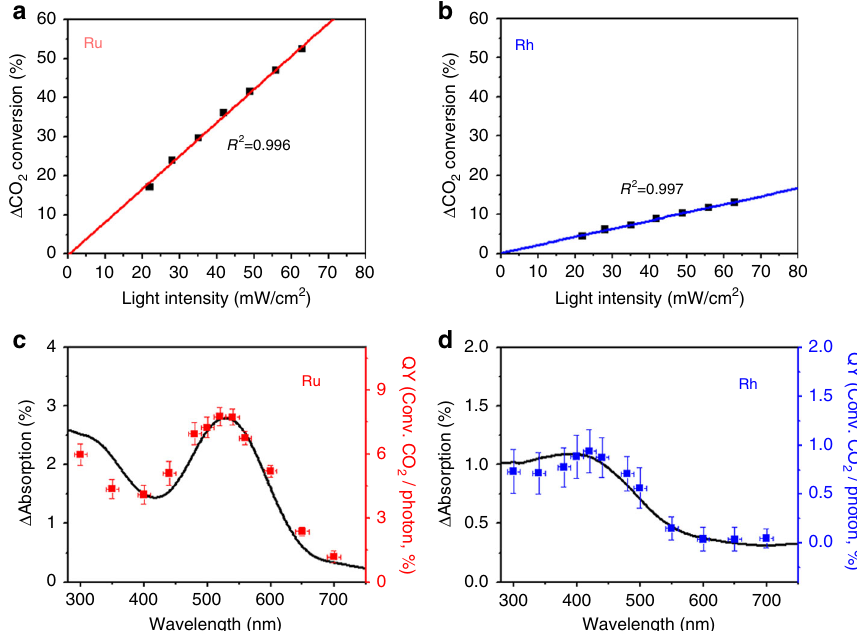
Fig. 2 Dependence on light intensity and light wavelength. a , b CO 2 conversion for CO 2 hydrogenation on Ru/SiO 2 and Rh/SiO 2 when the light intensity was varied. To clarify the relation between the light intensity and CO 2 conversion enhanced by the light, thermal CO 2 conversion without light was subtracted from light-assisted CO 2 conversion ( Δ CO 2 conversion). Light intensity after passing the sapphire window was measured by a spectroradiometer. c , d In-situ UV – Vis spectroscopy in CO 2 fl ow (black lines) and quantum yield for wavelength-dependent measurement of CO 2 hydrogenation on Ru/SiO 2 or Rh/SiO 2 (red or blue dots). Error bars in x -direction indicates full-width at half maximum intensity of monochromatic light. Error bars in y -direction indicates a deviation among three different measurements. The in-situ UV – Vis spectroscopy and CO 2 conversion was measured at 150 °C for Ru/SiO 2 and 200 °C for Rh/SiO 2 NATURE COMMUNICATIONS| (2018) 9:3027 |DOI: